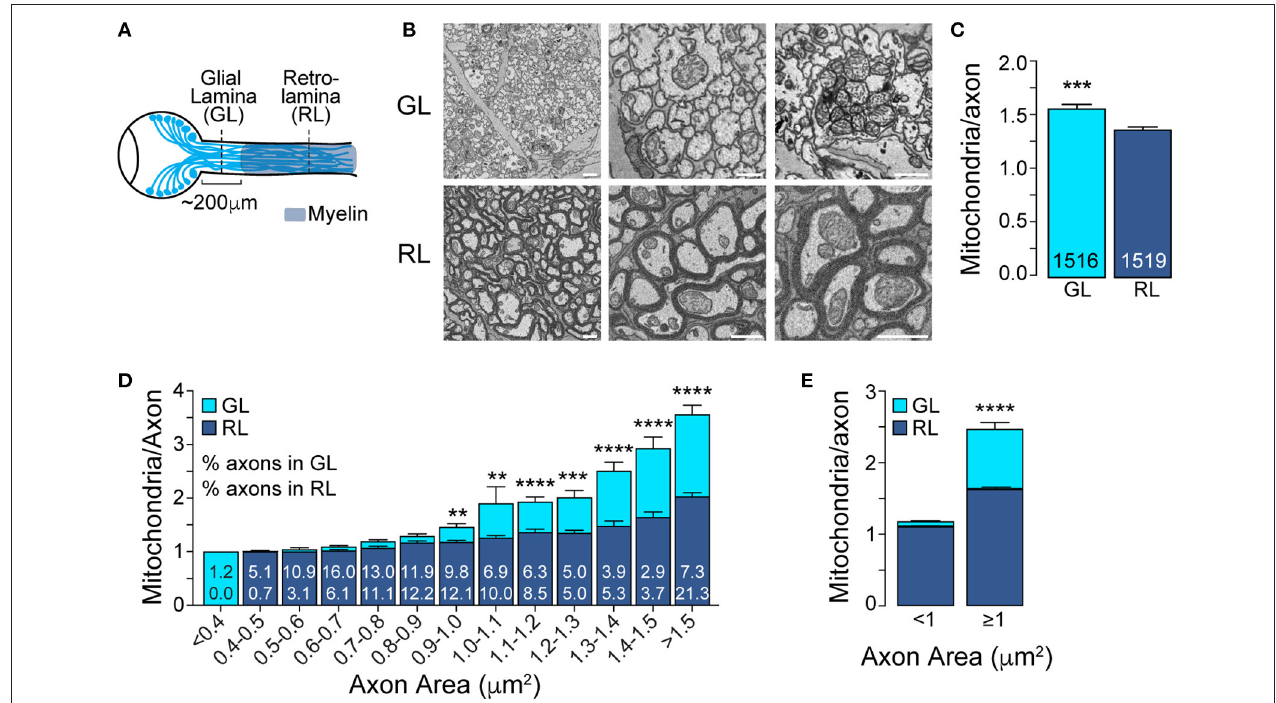
FIGURE 1 | The mitochondrial accumulation at the glial lamina is specific to larger axons. (A) Schematic of the adult mouse optic nerve. (B) Representative electron micrographs of optic nerve cross-sections obtained at the unmyelinated GL and myelinated RL regions. Scale bar = 1 µ m. (C) Average number of mitochondria per axon in the GL and RL regions. *** p = 0.0003, Mann–Whitney test. The total number of axons are indicated in the bars; n = 3 mice. (D) GL and RL average number of mitochondria per axon as a function of axonal area. The numbers within each superimposed bar represent the percentage of total axons falling within each area range for the GL (top) and RL (bottom). ** p < 0.002, *** p < 0.0006, **** p < 0.0001, Kruskal–Wallis test and Dunn’s multiple comparisons. ( E) Average number of mitochondria per axon in the GL and RL for axons with areas smaller or bigger than 1 µ m 2 . **** p < 0.0001, Kruskal–Wallis test and Dunn’s multiple comparisons. Error bars =